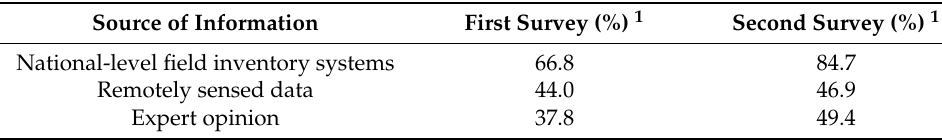
Table 1. Strategies for updating tree range